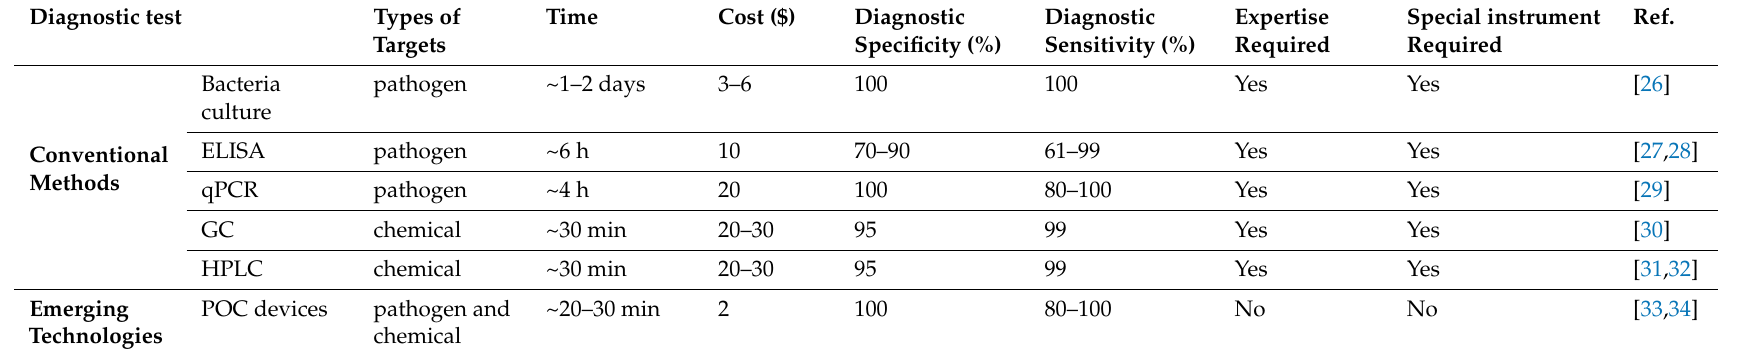
Table 1. Comparison of conventional and emerging food testing technologies.